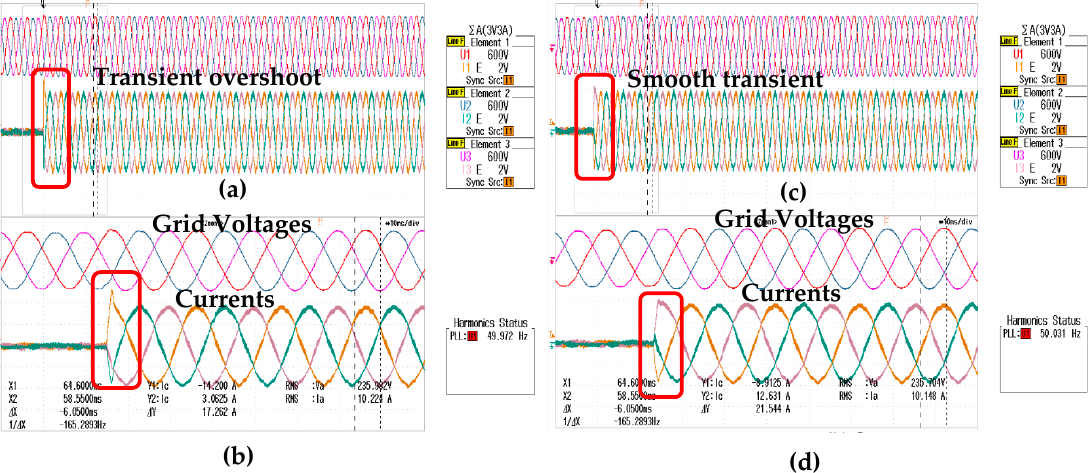
Figure 16. Experimental results captured from the oscilloscope: ( a ) Experimental results of grid voltages and current when K p = 7 and K r = 70; ( b ) Zoom in version of the grid voltages and currents shown in ( a ); ( c ) Experimental results of grid voltages and current when K p =7 and K r = 19; ( d ) Zoom in version of the grid voltages and currents shown in ( c ).